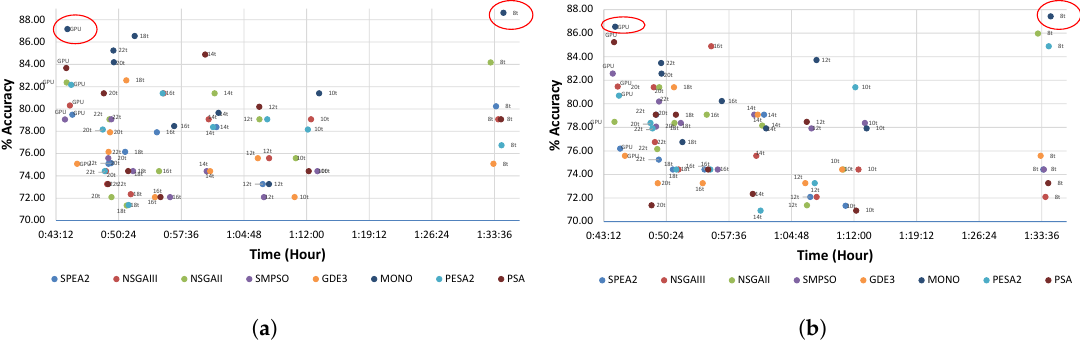
Figure 4. Time vs accuracy in the first and second stages. ( a ) first stage; ( b ) second